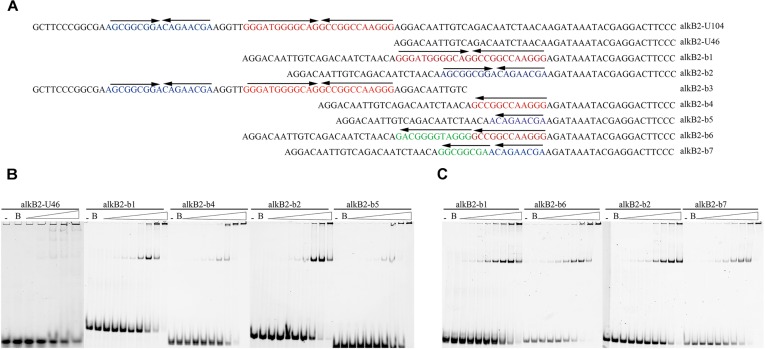
EMSA detection for the binding of CrgA protein to different DNA fragments. (A) Sequences of different DNA fragments for EMSA detection. The upper arrows of each oligonucleotides meant the direction of IIR structures. The alkB2-U104 was the sequences of the upstream 104 bp region of alkB2 gene. Fragment alkB2-U46 was the upstream 46 bp fragment of alkB2 gene without CrgA binding ability and was used for the insertion of different binding sites. The fragments alkB2-b1 and alkB2-b2 contained the full IIR structure of one binding site, bs1 or bs2; the fragment alkB2-b3 contained the two binding sites. The fragments alkB2-b4 and alkB2-b5 had only half of IIR structure of one binding site, bs1 or bs2. The destroyed IIR structure (reversed sequences) of bs1 or bs2, were in the fragments alkB2-b6 and alkB2-b7. (B) Native PAGE image of EMSA assay with CrgA protein to the fragments with IIR structure. The fragments alkB2-U46, alkB2-b1, alkB2-b2, alkB2-b4 and alkB2-b5 were used. (C) Native PAGE image of EMSA assay with CrgA protein to fragments with destroyed IIR structure. The fragmentsalkB2-b1, alkB2-b2, alkB2-b6 and alkB2-b7 were used. The input fragments in each sample were 4 pmol and the molar ratios of CrgA/DNA fragment ranged from 0.5:1, 1:1, 2:1, 4:1, 8:1, 16:1, 32:1, and 64:1 (from left to right). The lane marked dash meant the free DNA fragment without protein. The lane marked B was the DNA fragment mixed with BSA protein in 64:1 molar ratio.